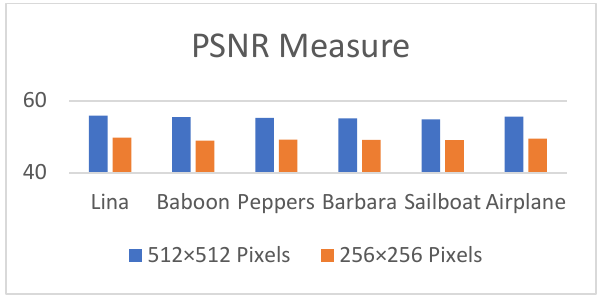
Figure 4. PSNR measure for embedding 2000 bytes in colour images of sizes 512 × 512 and 256 × 256.